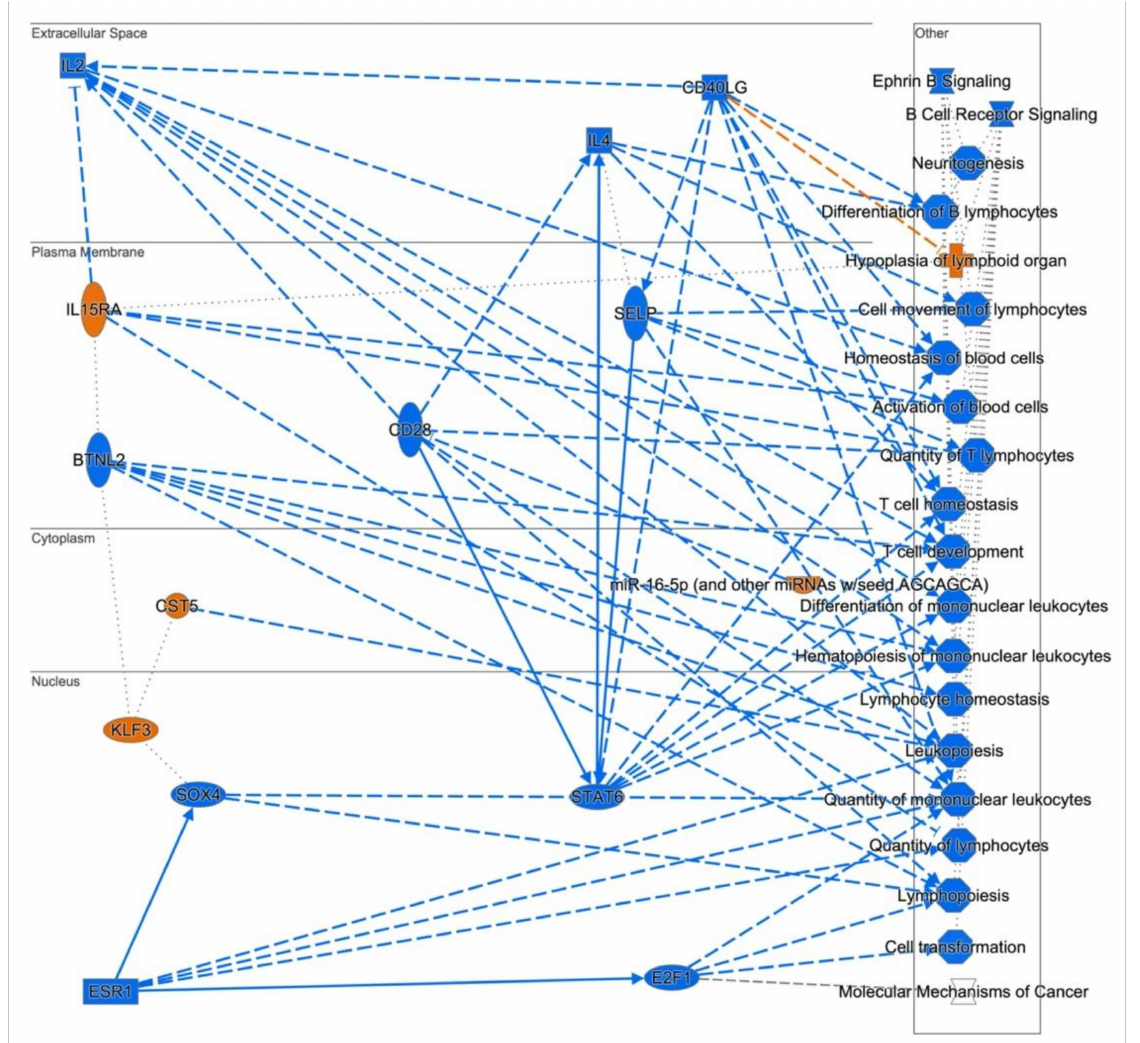
Figure 10. Graphical summary of expression profiling of human lymphoblastoid cells derived from an SS patient. Many of the processes affected in these types of cells are essential for lymphocyte differentiation and formation, homeostasis, cell survival and B Cell receptor signaling. Includes all entities with p < 0.05 and z score ≥ 2 for diseases, functions and upstream regulators. Orange entities repre-sent activated nodes with z score ≥ 2, while blue entities represent inhibited nodes with z score ≤ − 2. Vertical ellipses represent transmembrane receptors, horizontal ellipses = transcription regulators, rectangular bar = ligand-dependent nuclear receptor, squares = cytokines or growth factors, octagons = function, crosses = disease, squeezed rectangle = ca-nonical pathway and circles =